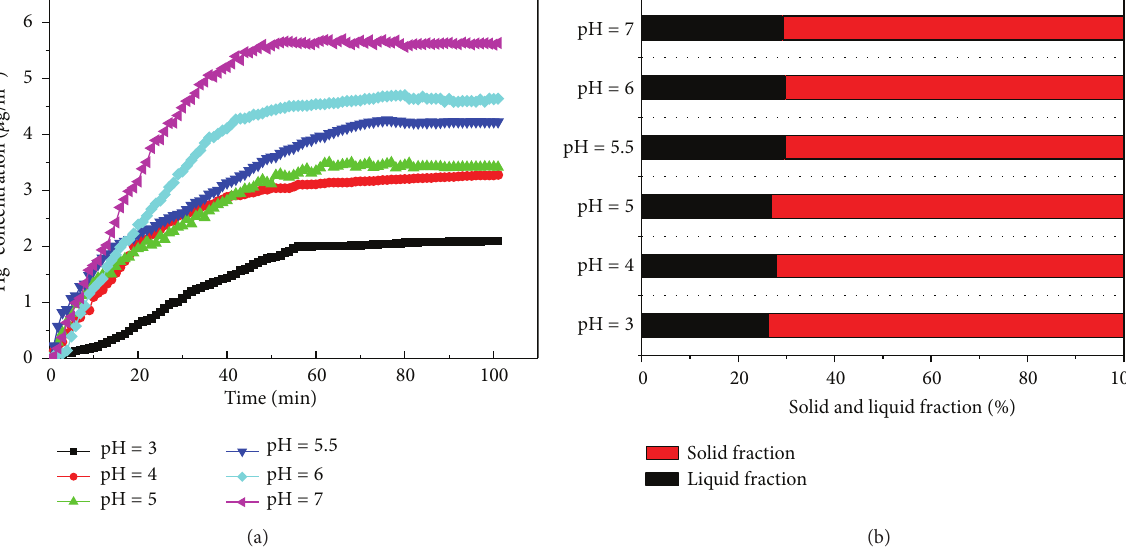
Figure 4: (a) Effect of the pH on Hg 0 reemission. (b) Relationship between the proportion of mercury retained in the solid and liquid fraction of the slurry and the